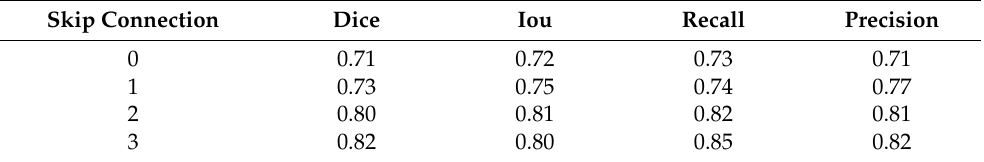
Table 6. The effect of the number of jumps on the segmentation ability of the model. Skip